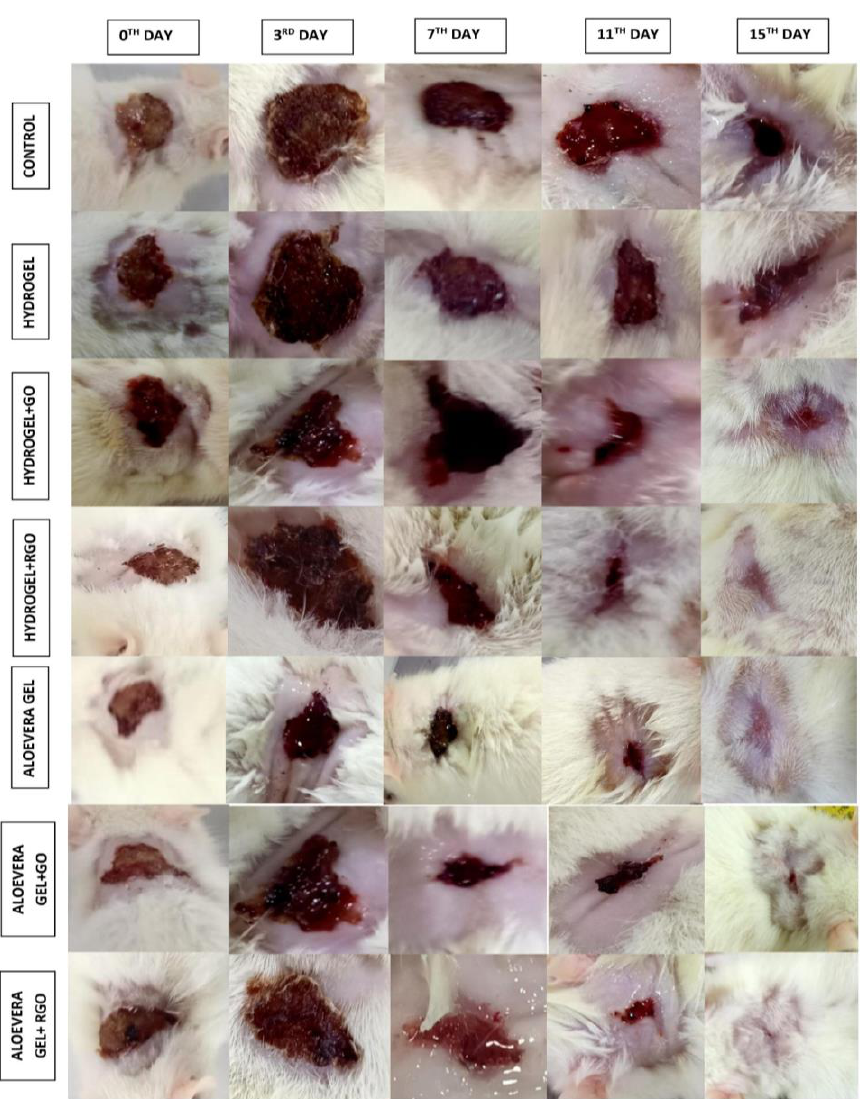
Figure 15. Wound contraction rate of GO and rGO-based composite gels. The measurement of wound contraction is a major standard for the indication of radical wound healing which is expressed as the decrement in the wound diameter from the surgery date (0th, 3rd, 7th, 11th, and 14th days).